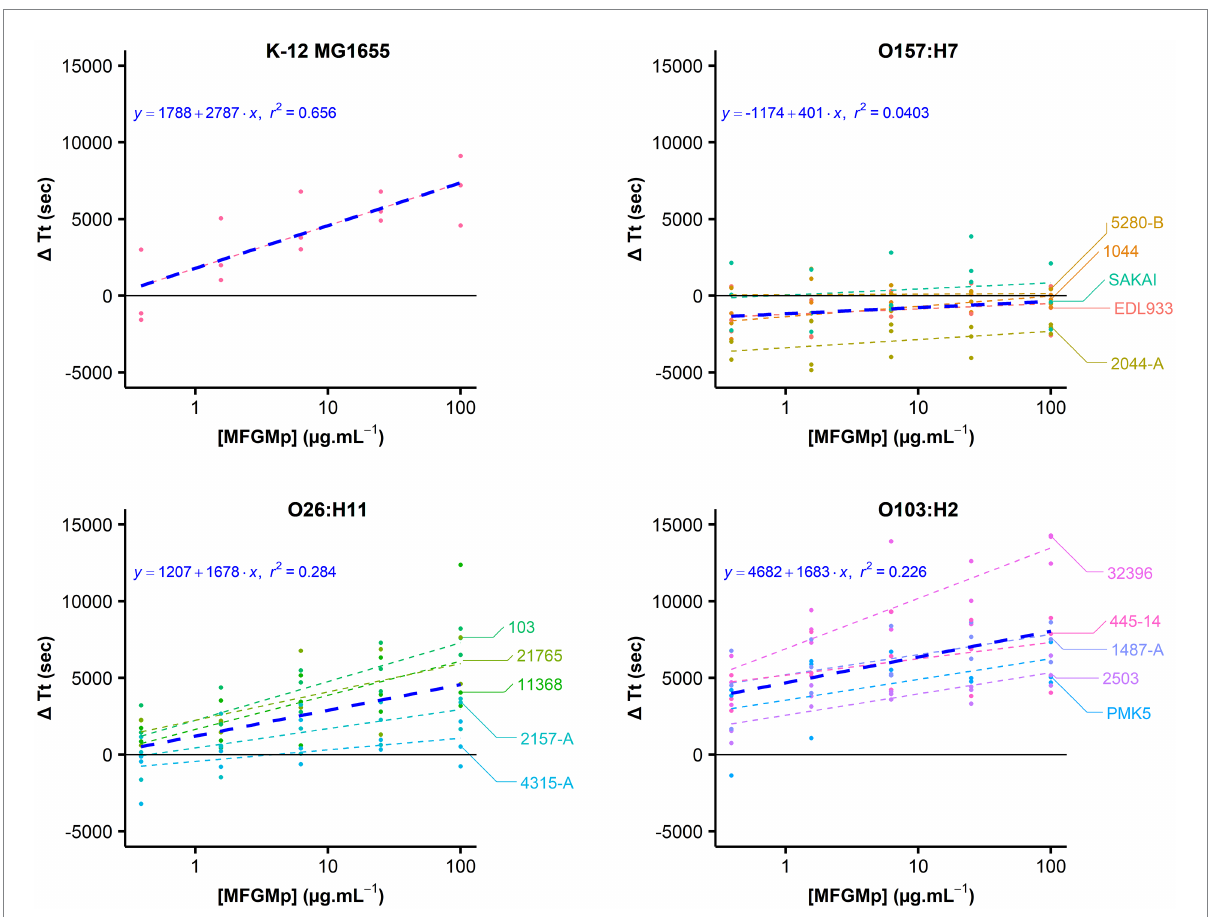
FIGURE 3 STEC adhesion to MFGMPs. The adhesion of E. coli to MFGMPs was evaluated by plate washing assay. Bacterial cells were added to wells previously coated with 100, 25, 6.25, 1.56, 0.39, or 0 μ g.mL − 1 MFGMPs at 4 ° C for 2 h. After extensive washing, growth curves were acquired in a plate reader and the time of each curve to reach an absorbance of 0.02 at 600 nm (Time Threshold; Tt) was estimated by a five-parameter log- logistic. The points represent the difference of Tt ( Δ Tt in sec) with and without MFGMPs. It was calculated for each coating solution, strain, and experimental replicate. For each strain, a dashed-line was plotted as a function of the median Δ Tt for each MFGMP concentration (Log 10 scale). Each strain is represented by a distinct color. The blue line represents the median of Δ Tt for each MFGMP concentration at the serotype level. Three independent overnight bacterial cultures were used for each strain and assayed on different plates/days. The median and the standard deviations were